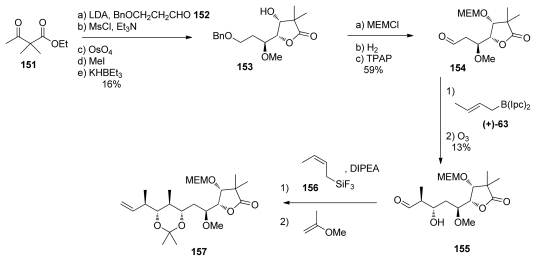
Preparation of 157.